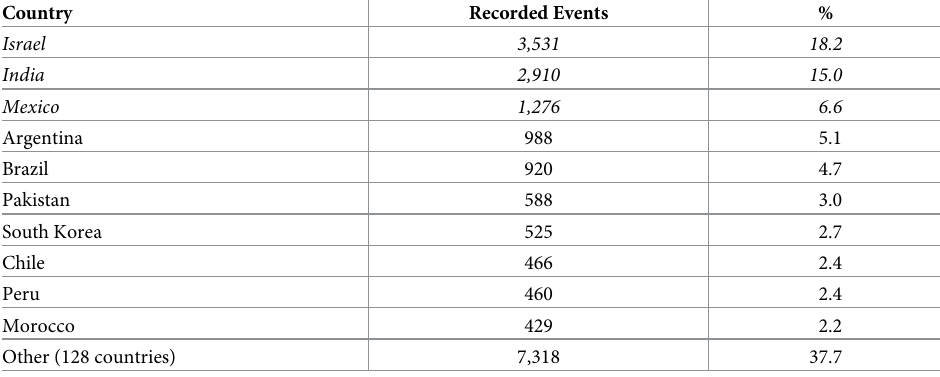
Table 1. Distribution of disorder events (violence against civilians, riots, protests, battles) across the top 10 coun- tries as tallied by ACLED between January 3 rd and December 12 th 2020. The countries considered in this study, India, Israel and Mexico are italicized, and account for almost 40% of the world total. At this time of writing, ACLED does not report data for the US.